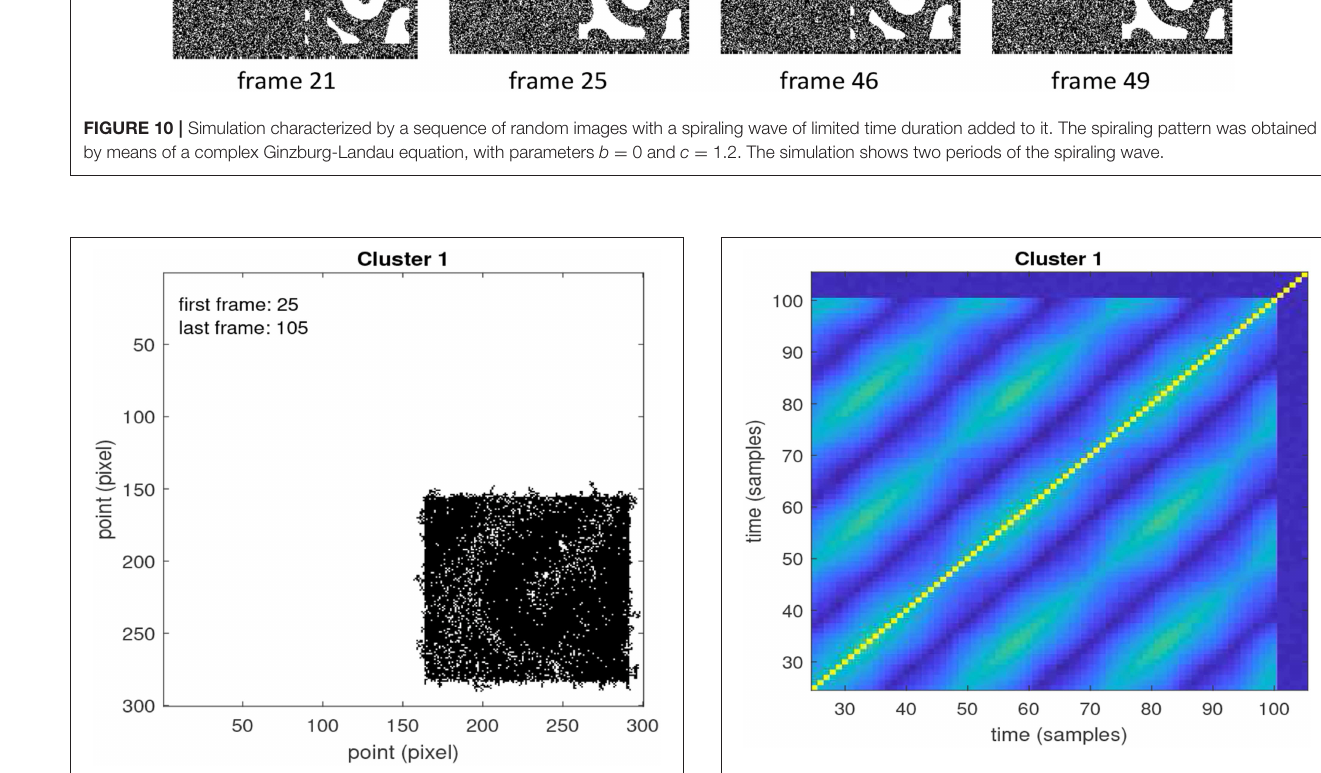
FIGURE 11 | Result of applying the framework for spatio-temporal detection of recurrence introduced in section 3.1 to the example of Figure 10 . The estimated time interval of the recurrent pattern is also shown.